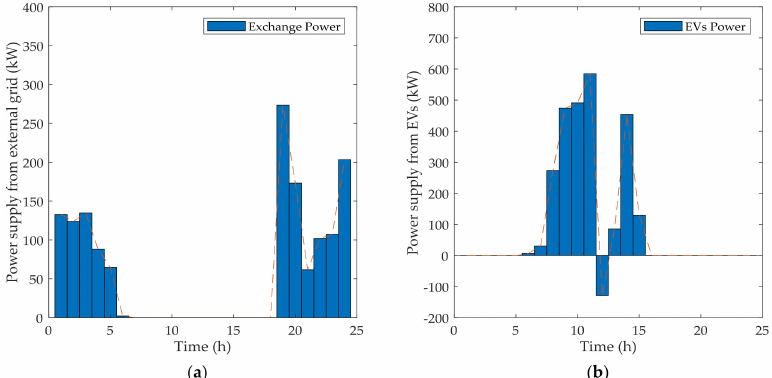
Figure 9. Electrical power supply in Case 1: ( a ) from the external grid and ( b ) from EVs.